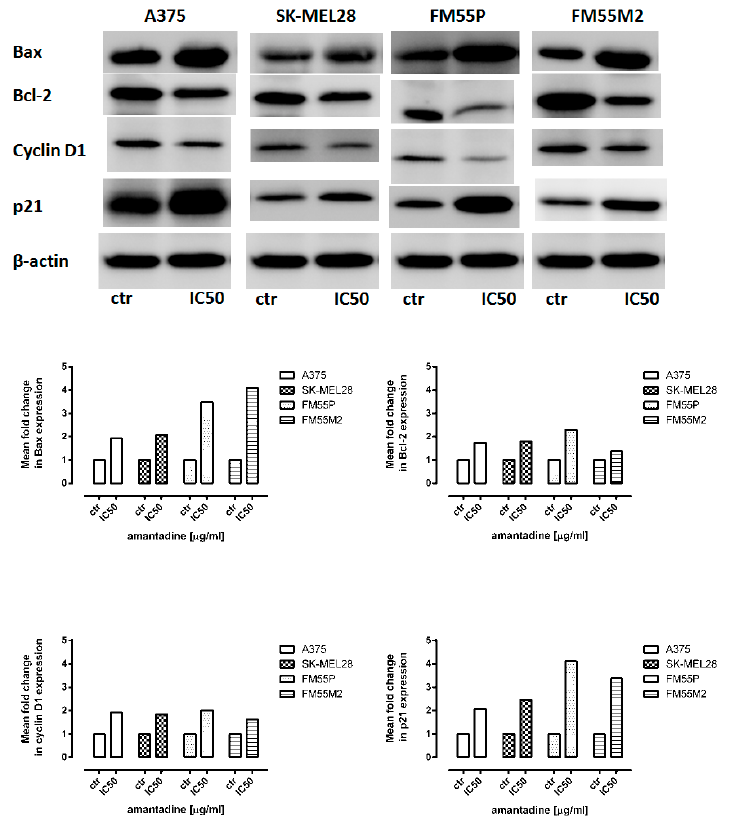
Figure 6. Representative blots of Bax, Bcl-2, cyclin-D1 and p21 proteins following incubation of melanoma cells with either culture medium alone (control) or amantadine at an IC 50 concentration.